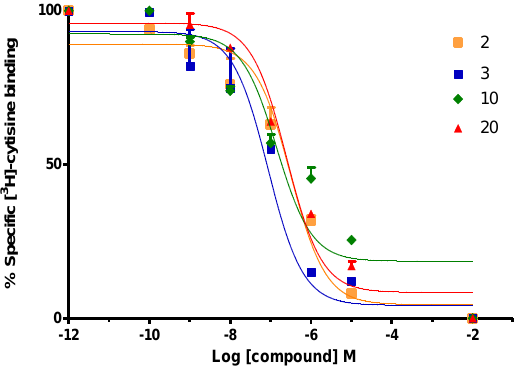
Figure 5. Compounds e ff ects on binding of [ 3 H]-cytisine to α 4 β 2 nAChRs. Data points represent the mean ± SEM of four experiments, each one carried out in triplicate. The radioligand concentration in all displacement studies was 1 nM.